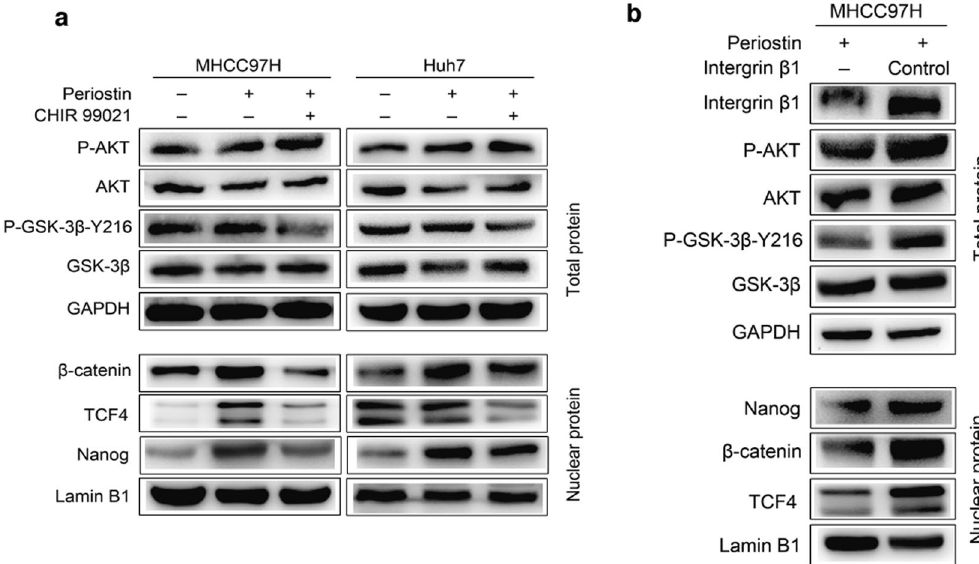
Figure 3. POSTN promoted the stemness of heat-exposed residual HCC cells via integrin β 1/AKT/GSK- 3 β / β -catenin/TCF4/Nanog signaling pathway. Western blots were performed. ( a ) POSTN upregulated the phosphorylation level of AKT and GSK-3 β , and the expression of nuclear β -catenin, TCF4 and Nanog in heat-exposed residual MHCC97H and Huh7 cells. The levels of GSK-3 β phosphorylation, β -catenin, TCF4 and Nanog expression were reduced by the administration of GSK-3 β inhibitor CHIR 99021. ( b ) Integrin β 1 knockdown attenuated POSTN-induced levels of AKT and GSK-3 β phosphorylation, β -catenin, TCF4 and Nanog expression in heat-exposed residual MHCC97H